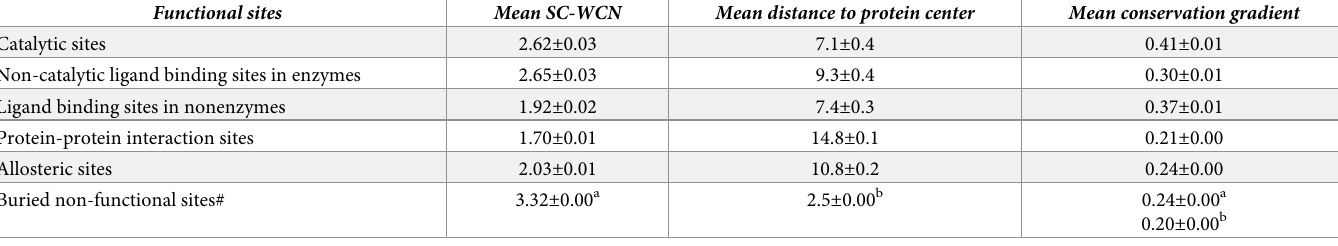
Table 1. Average side-chain weighted contact number (SC-WCN) and distance to the protein center as well as average conservation gradient of the different types of functional